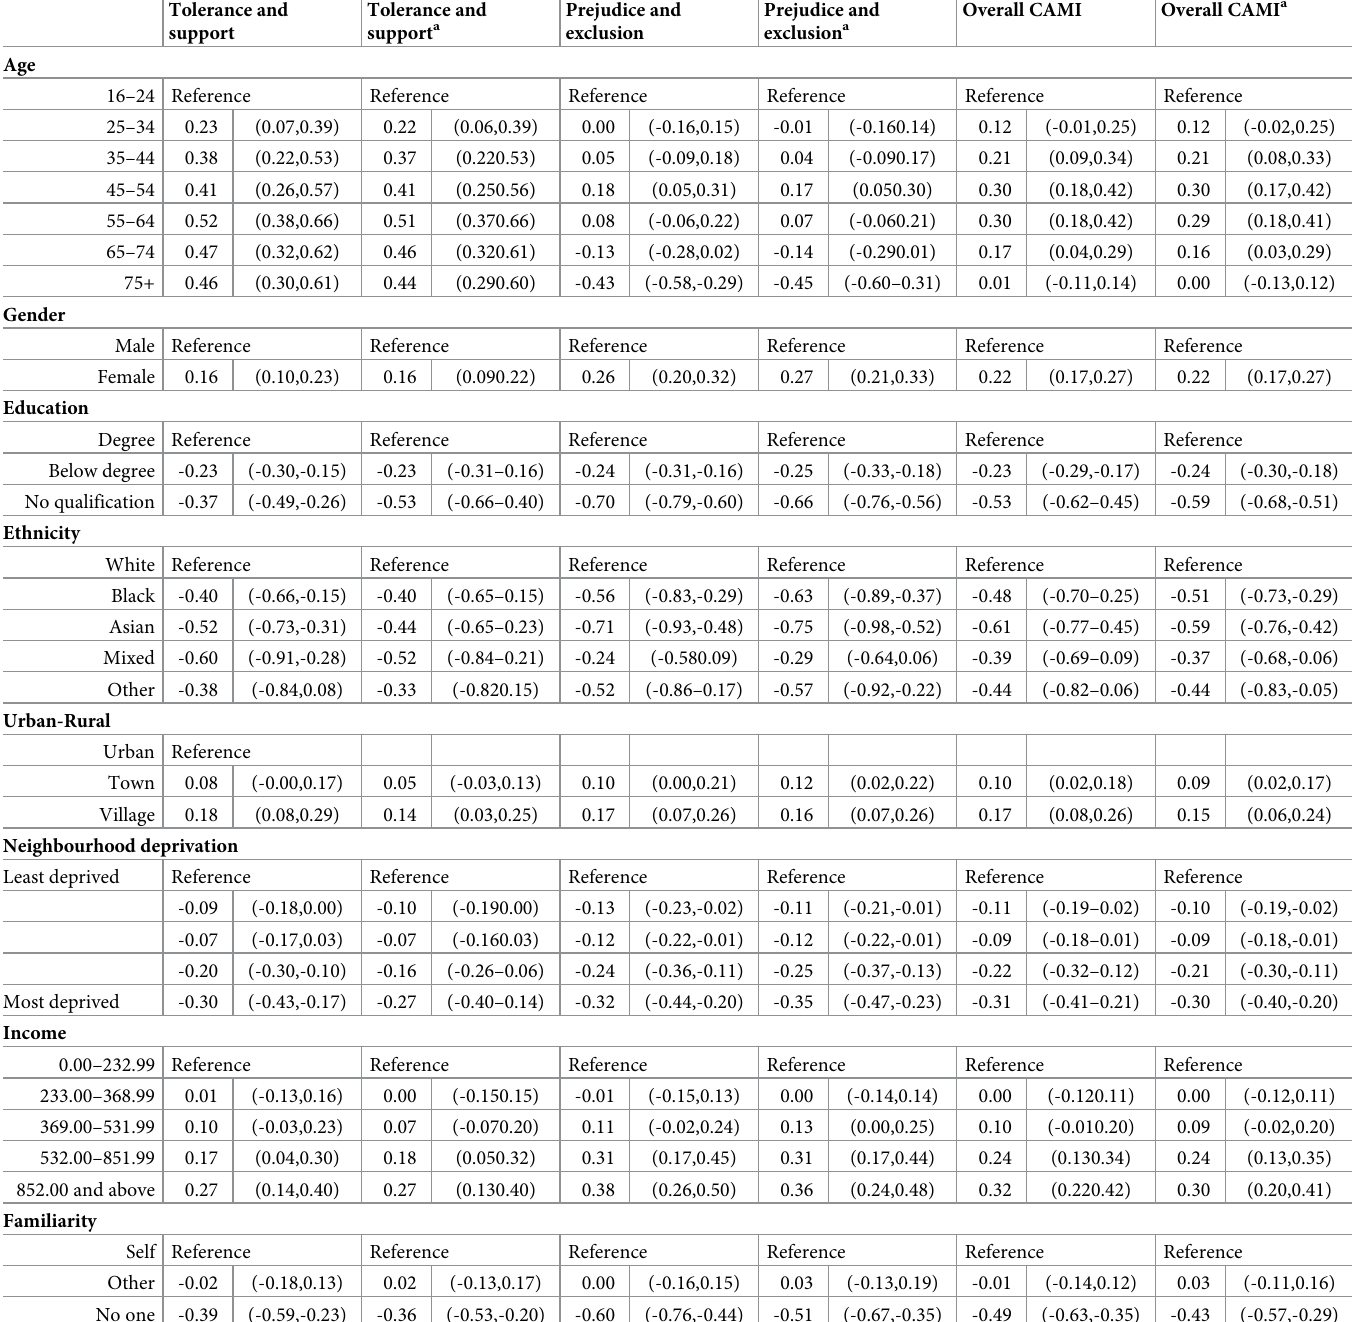
Table 2. Unadjusted, and age- and gender-adjusted associations(standardized mean differences) between attitude scores and each covariate, weighted for survey design and